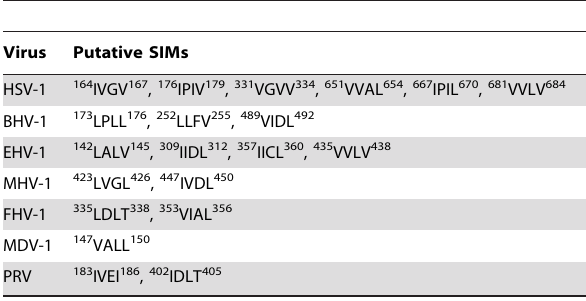
Table 1. Prediction of putative SIMs in ORF61 orthologs of other alphaherpesviruses.